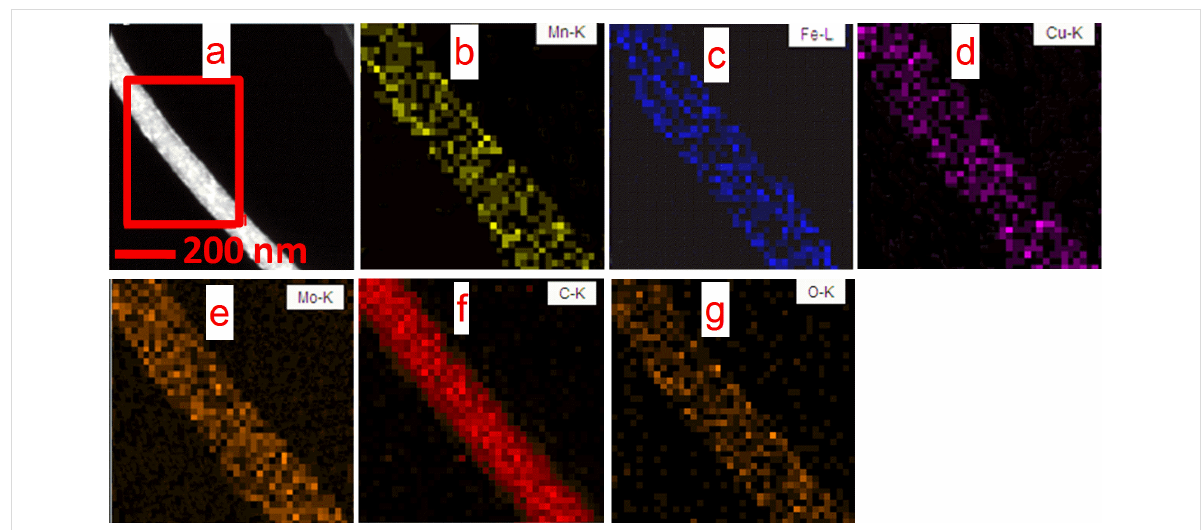
Figure 5: (a) STEM images and (b – g) element mappings of 4% MnO 2 –CuO–Fe 2 O 3